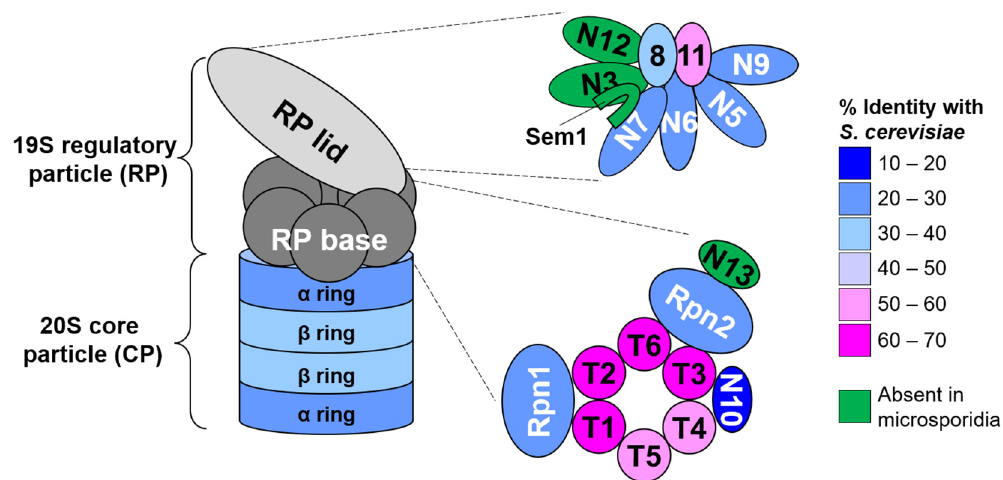
Figure 1. Ultrastructure and conservation of the N. ceranae 26S proteasome. Cartoon model of the canonical 26S proteasome. The 19S regulatory particle (RP) consists of lid and base subcomplexes. Detailed subunit compositions are shown to the right. The 20S core particle (CP) consists of four stacked heteroheptameric rings of α and β subunits. The coloring of the subunits indicates their sequence identity with their respective S. cerevisiae orthologs. For the CP, the average sequence identity of the seven subunits is displayed. Subunits shown in green appear to be absent from N. ceranae and all other microsporidia examined.